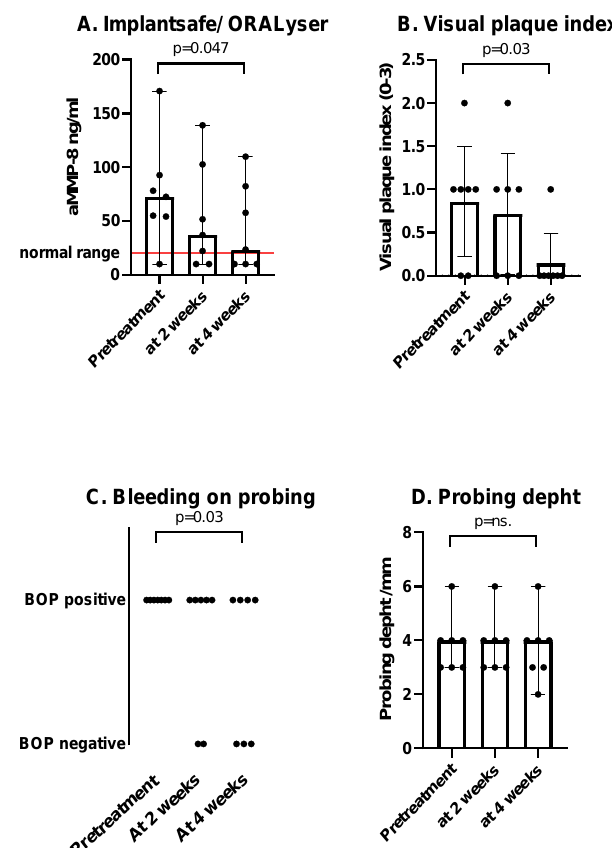
Figure 3. The dots represent the measured individual values, the bars represent the mean, and the error bars are the standard error of the mean. ( A ) There was a reduction in aMMP-8 measured from PISF between the pretreatment and after four weeks of treatment. The red line represents the normal value in PISF measurements in implant patients. ( B ) After two weeks of single-use of the dual-light aPDT device, a suggestive reduction in VPI was measured. After the subsequent use of twice a day, VPI was significantly lower. ( C ) Bleeding on probing was positive in all study subjects at the beginning of the study. However, it was measured negative in three patients at four weeks. ( D ) One implant pocket showed a reduction in PD during the four-week study period.